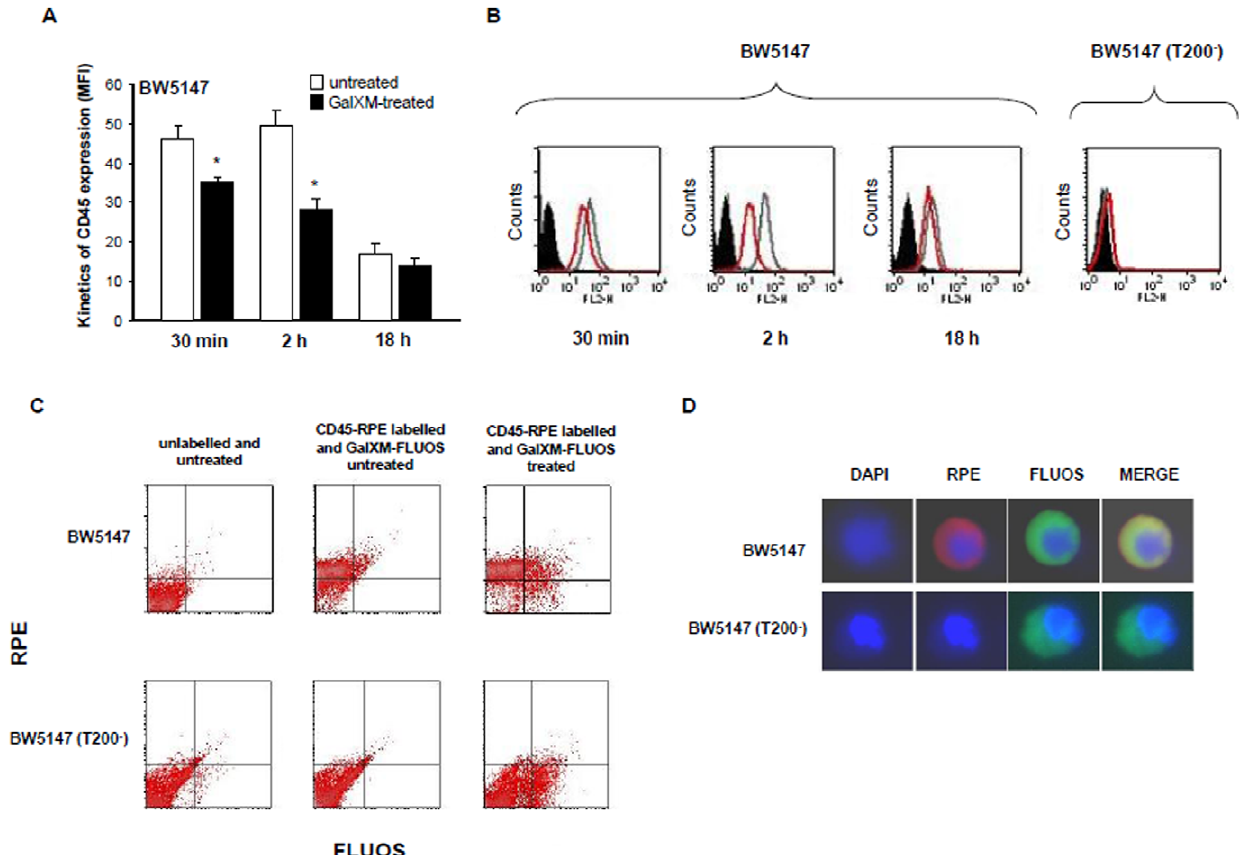
Figure 2. CD45 expression on BW5147 cells treated with GalXM and GalXM colocalization with CD45. BW5147 and BW5147 (T200 2 ) cells (both 1 6 10 6 /ml) were incubated for 30 min, 2 h or 18 h in the presence or absence of GalXM (10 m g/ml). After incubation, cells were labelled with RPE mAb to CD45 and analyzed by FACScan flow cytometry. The mean of fluorescence intensity (MFI) of labelled cells is shown as a histogram ( A ) or is shown as FACScan histograms ( B ). Error bars denote s.e.m. *, p , 0.05 (GalXM-treated vs untreated, n=7). In selected experiments, cells (1 6 10 6 /ml) were incubated for 30 min in the presence or absence of GalXM-FLUOS (10 m g/ml). After incubation, cells were labelled with RPE mAb to CD45 and analyzed by FACScan flow cytometry. Dot plots of the percentage of double positive cells, from one representative experiment out of five with similar results, were reported ( C ). Cells (1 6 10 6 /ml) were incubated for 30 min with GalXM-FLUOS (10 m g/ml) (green), labelled with RPE mAb to CD45 (red), stained with DAPI (blue) and subsequently examined under fluorescent light microscopy